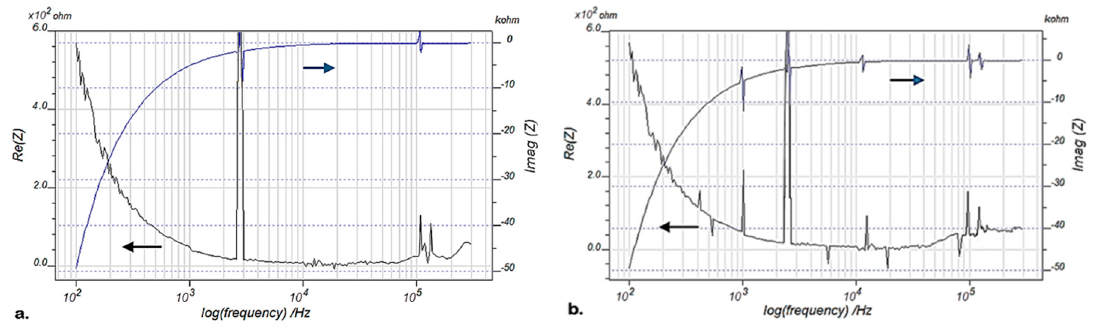
Figure 6. Real and imaginary EMI for the blade L 1 , frequency sweep at 100 Hz–300 kHz using IVIUM analyzer at 200 °C; ( a ) pristine blade and ( b ) damaged blade.